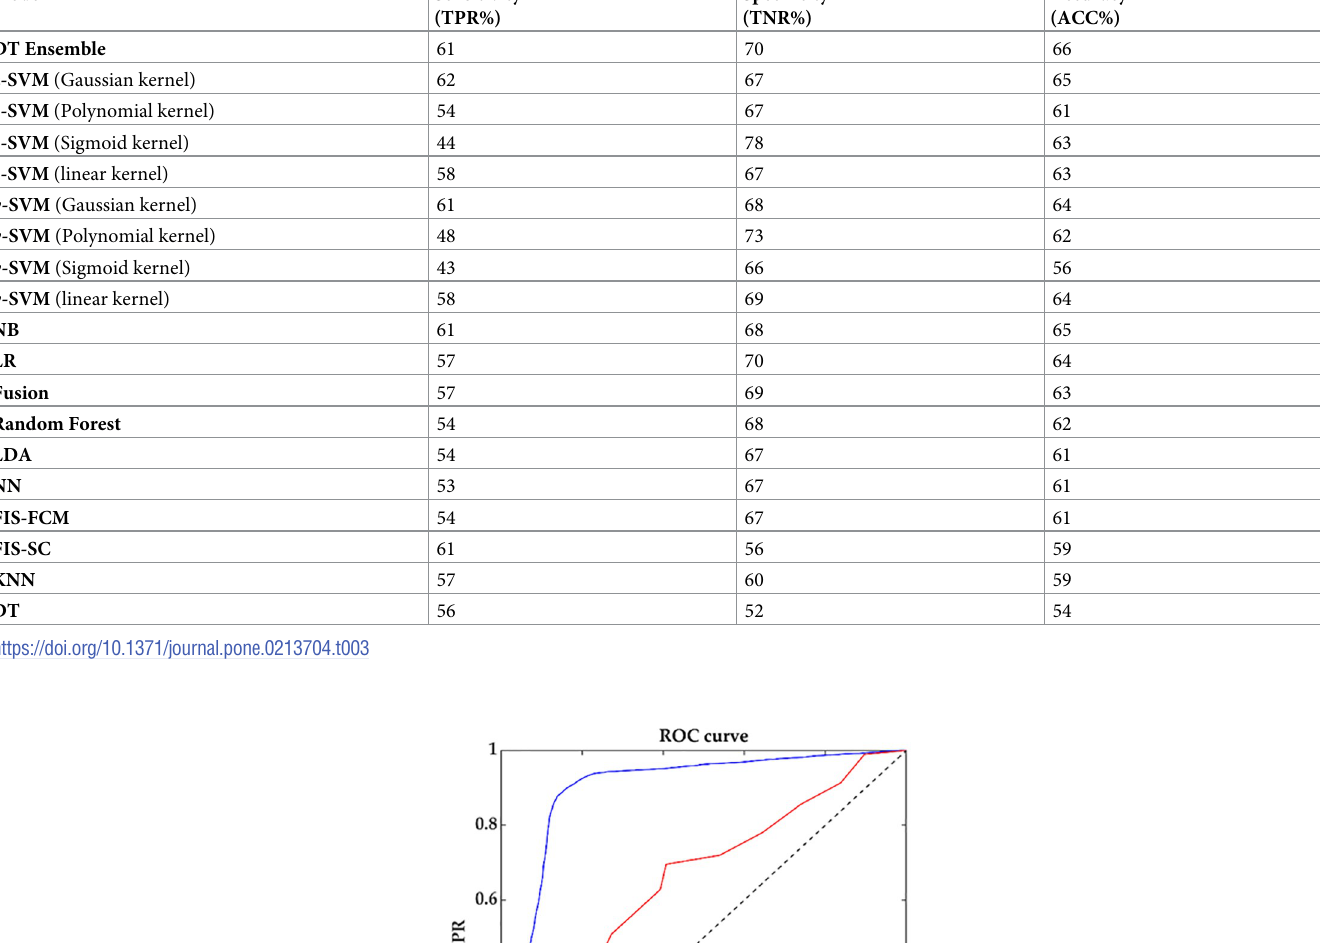
Table 3. The performance of the models to classify the state of fatigued (KSS � 5) (Positive class) from alert (Negative class). Model